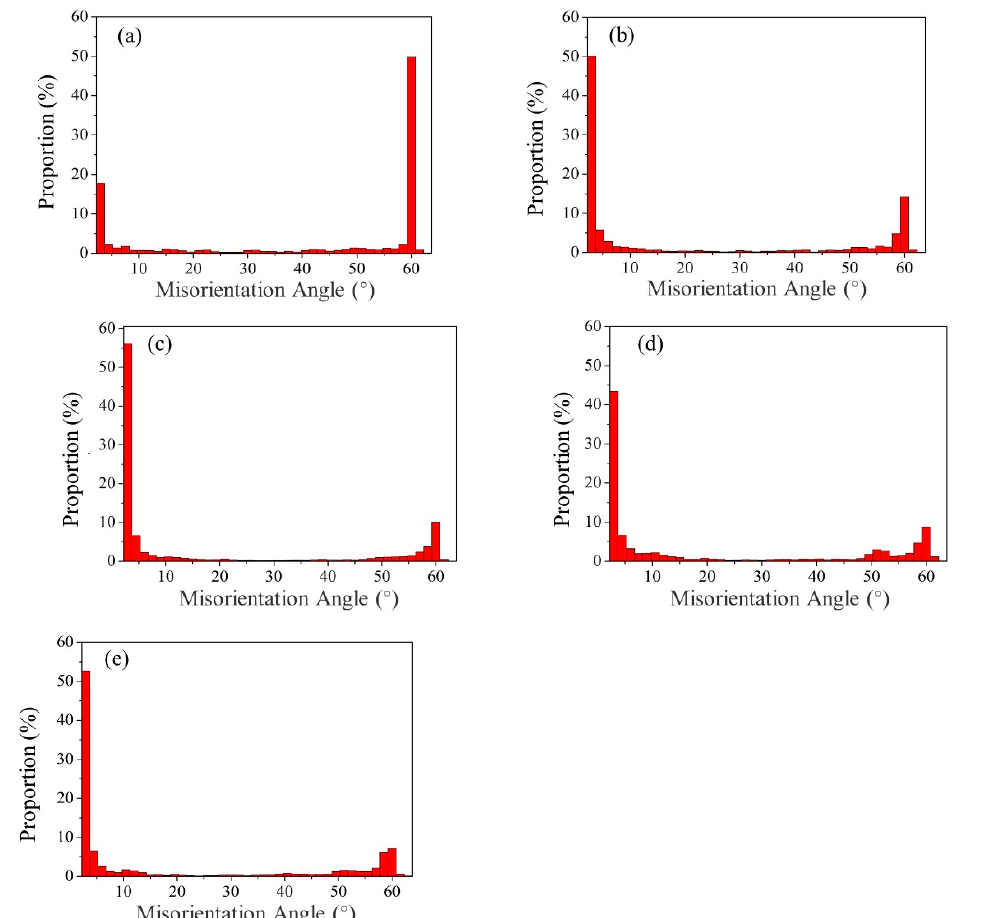
Figure 7. GBMA distribution maps of the welded joint. ( a ) BM. WMZ under different welding speeds (mm/min): ( b ) 280, ( c ) 300, ( d ) 320, and ( e ) 340.